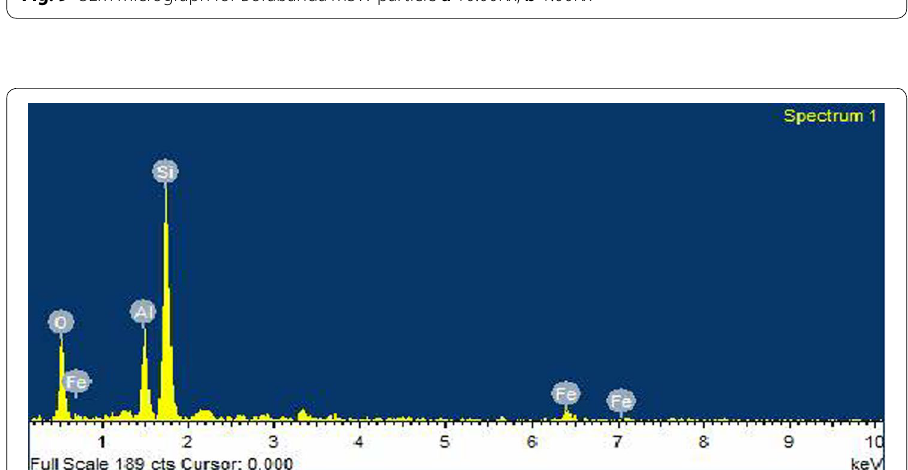
Fig. 10 Energy dispersive X-ray (EDX) graphs of KTPS fly